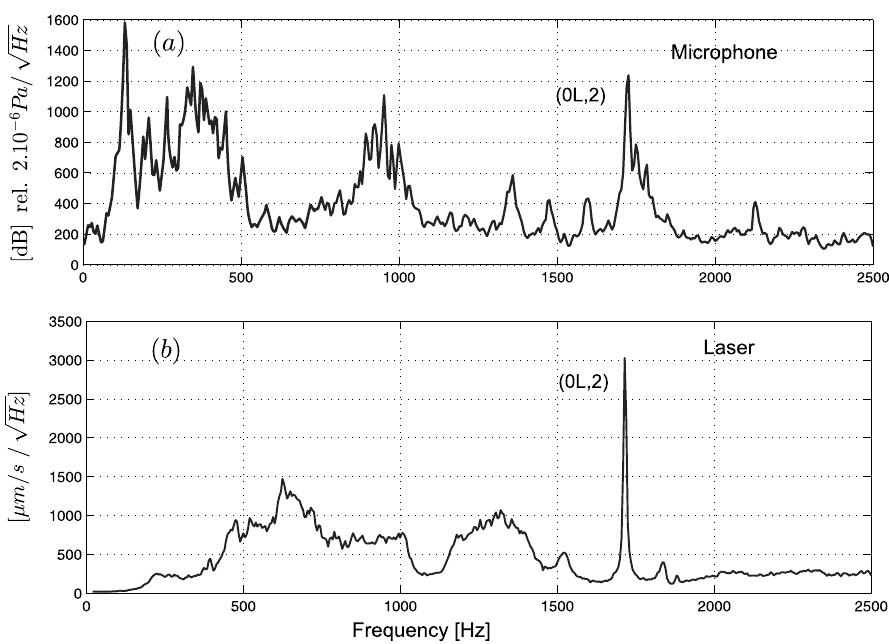
Fig. 9. Frequency spectrum averaged during the time of the experiment of (a) The sound emitted from the wheel-rail contact; (b) The lateral velocity of the wheel set.